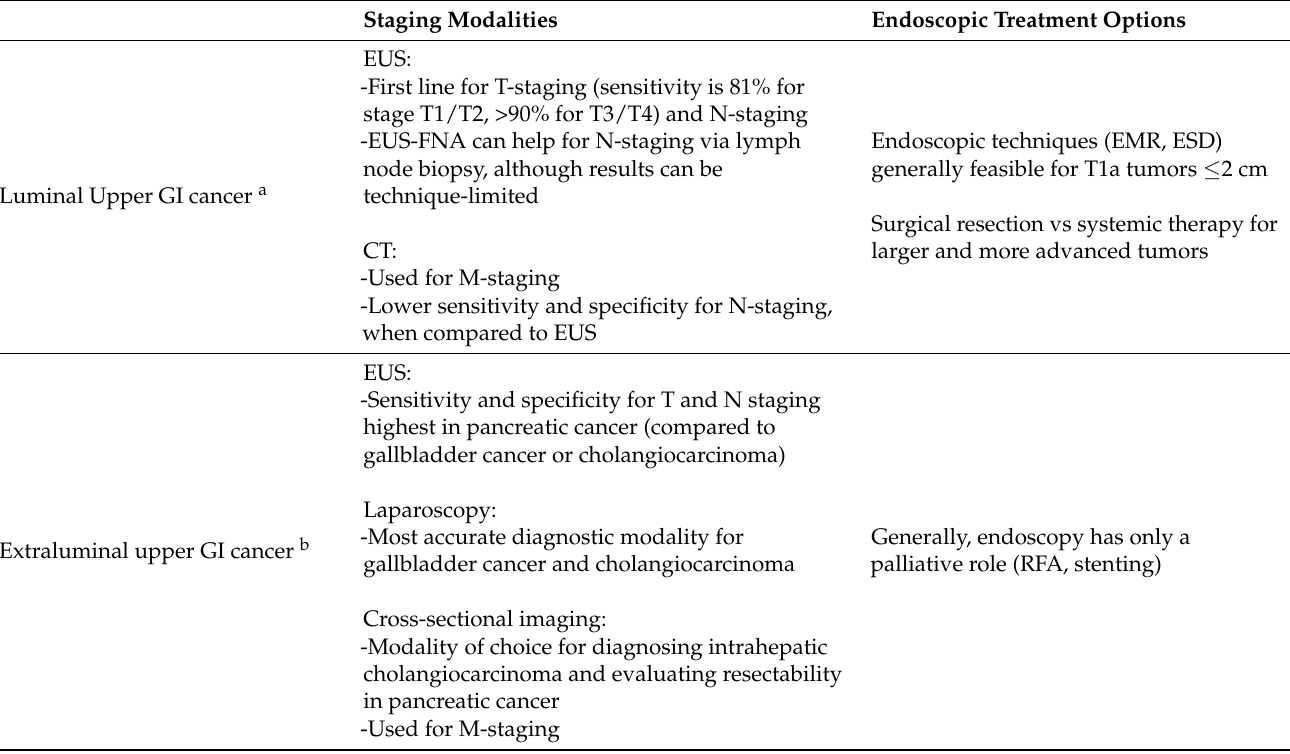
Table 3. Upper GI cancer Staging and